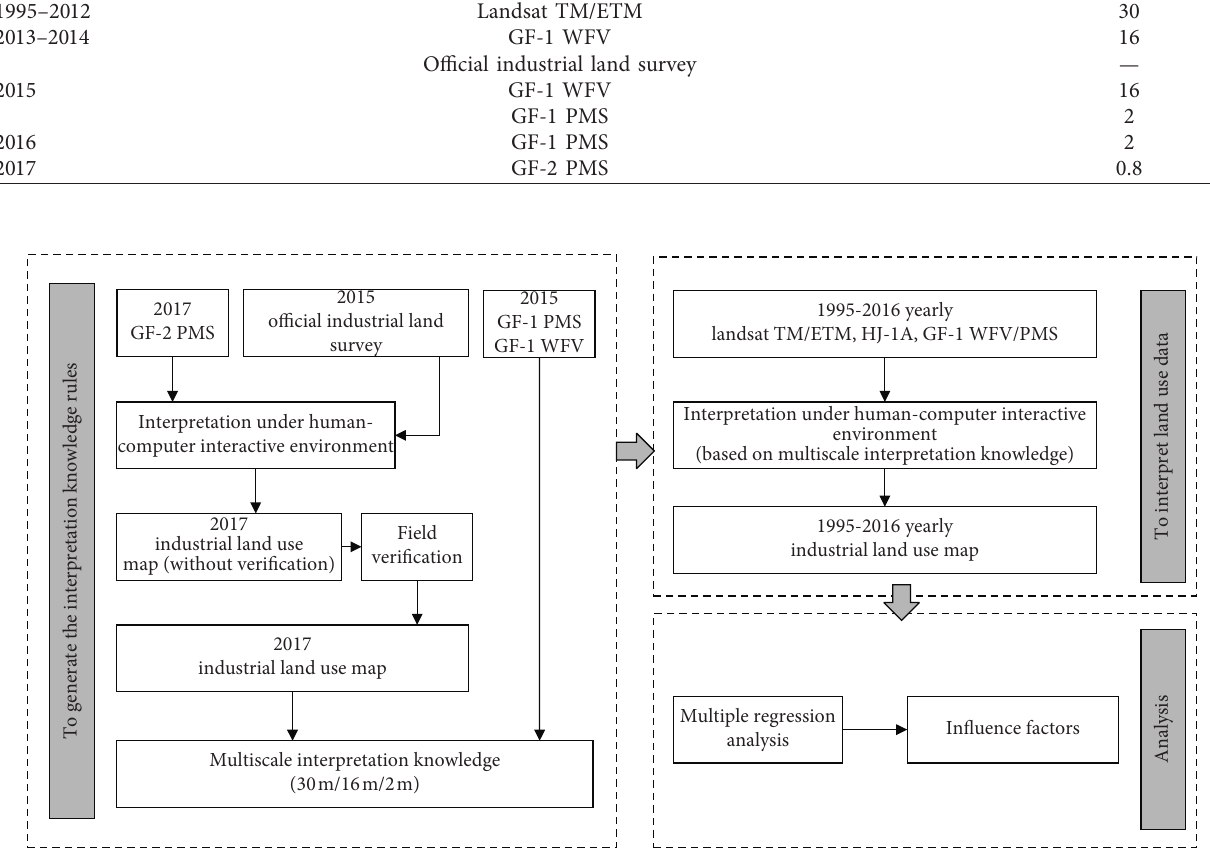
Figure 3: Data processing.